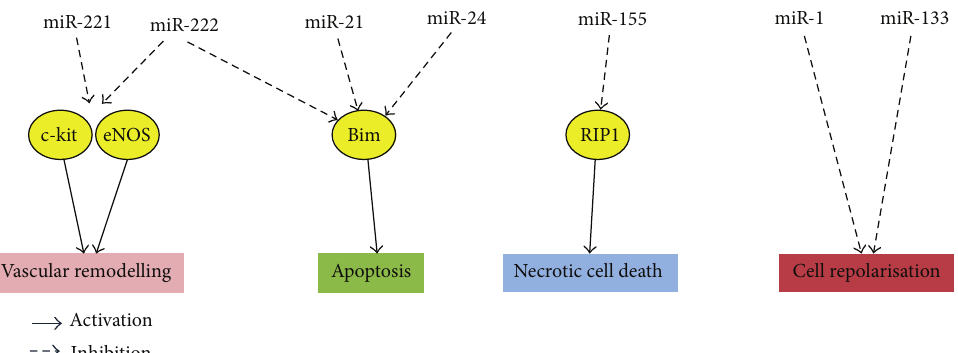
Figure 3: Pathophysiological effect of various miRs on vascular remodelling. Apoptosis, necrotic cell death, and potassium channel function. miRs within cardiac stem cells and progenitor cells regulate a number of known pathophysiological conditions. The effect of each miR subtype on these conditions as well as their associated target proteins is summarised in this diagram (inhibition is indicated by the dashed arrows and activation is indicated by solid